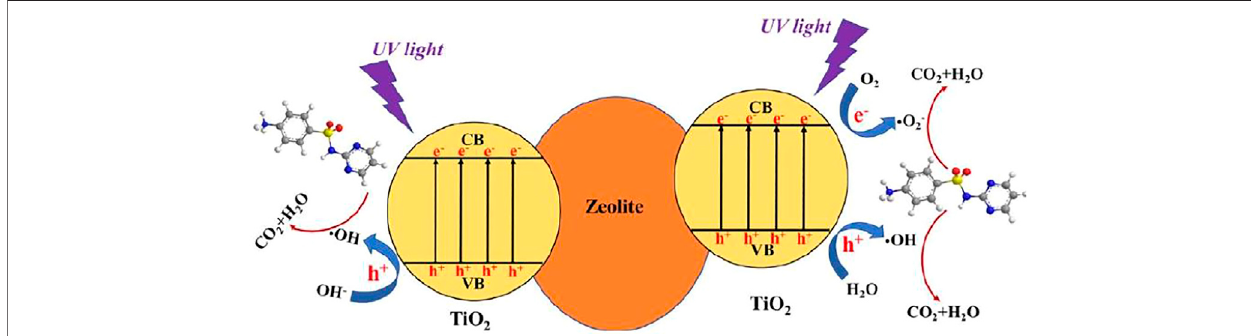
FIGURE 5 | Catalytic degradation mechanism diagram of TiO 2 /zeolite composite material